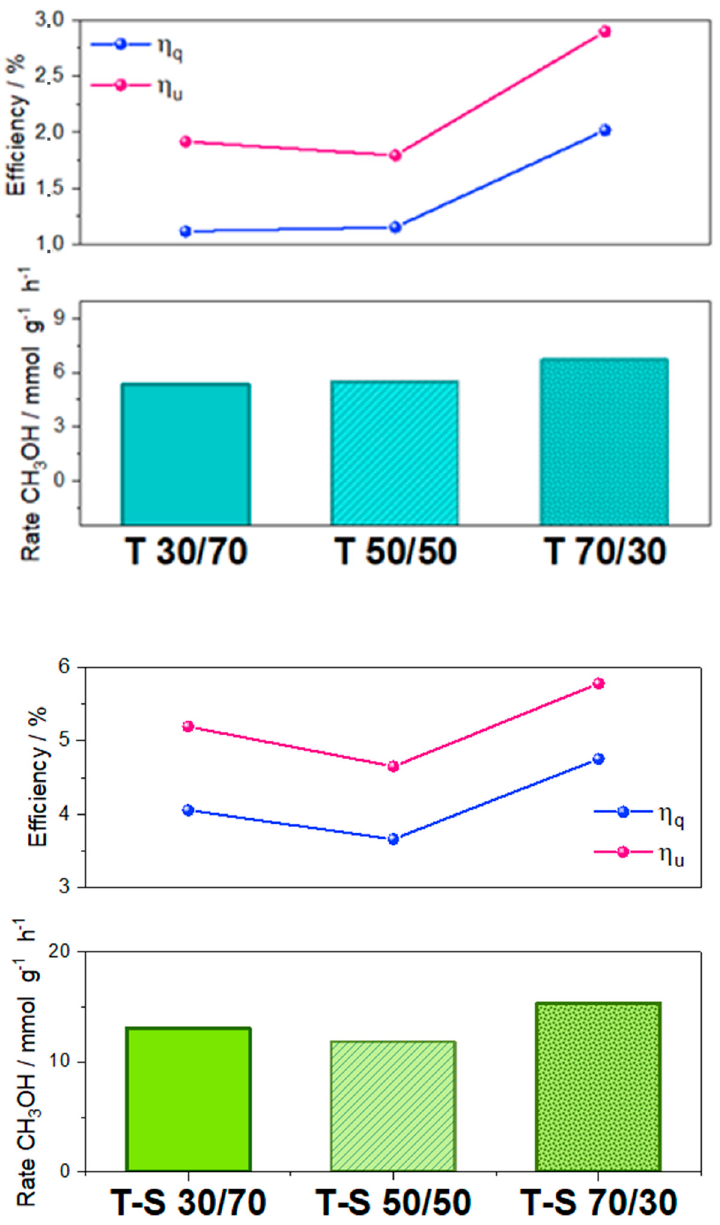
Figure 8. Reaction rate and efficiency observables (quantum efficiency, η q , and photon usage, η u ) for the T and T-S samples as a function of the methanol content of the reaction mixture.